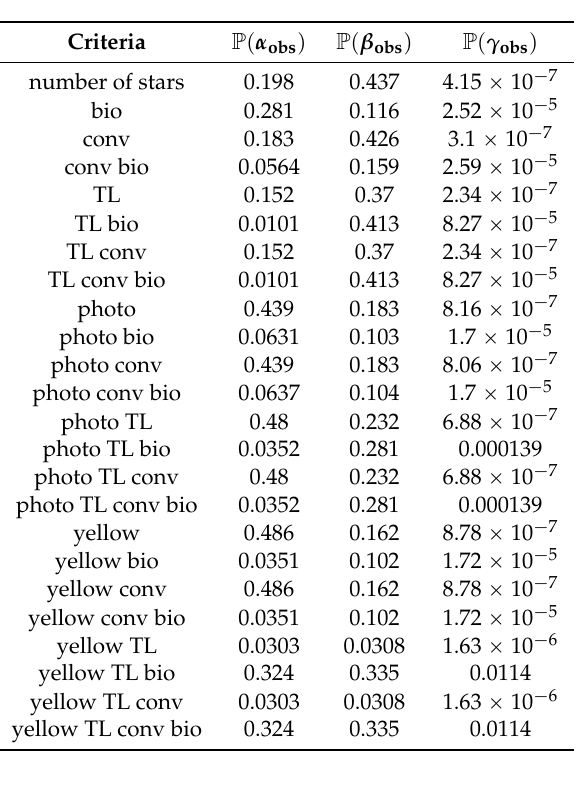
Table 2. Probabilities of observing our values of parameters for various habitability hypotheses. Here the shorthands are photo: Photosynthesis criterion, TL: Tidal locking, conv: Convective stars, and bio: The biological timescale